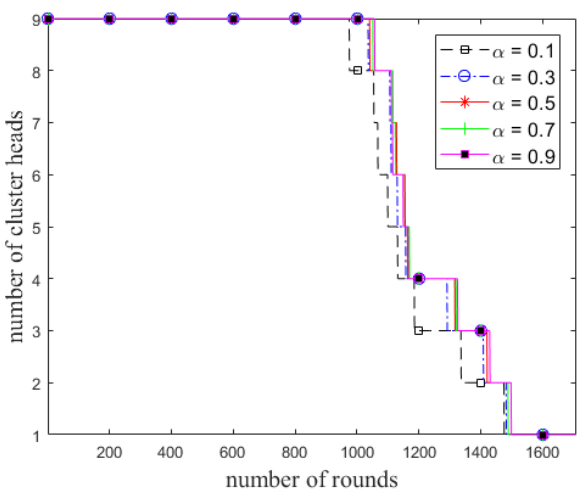
Figure 3. Number of elected cluster heads in each round in ECCR.